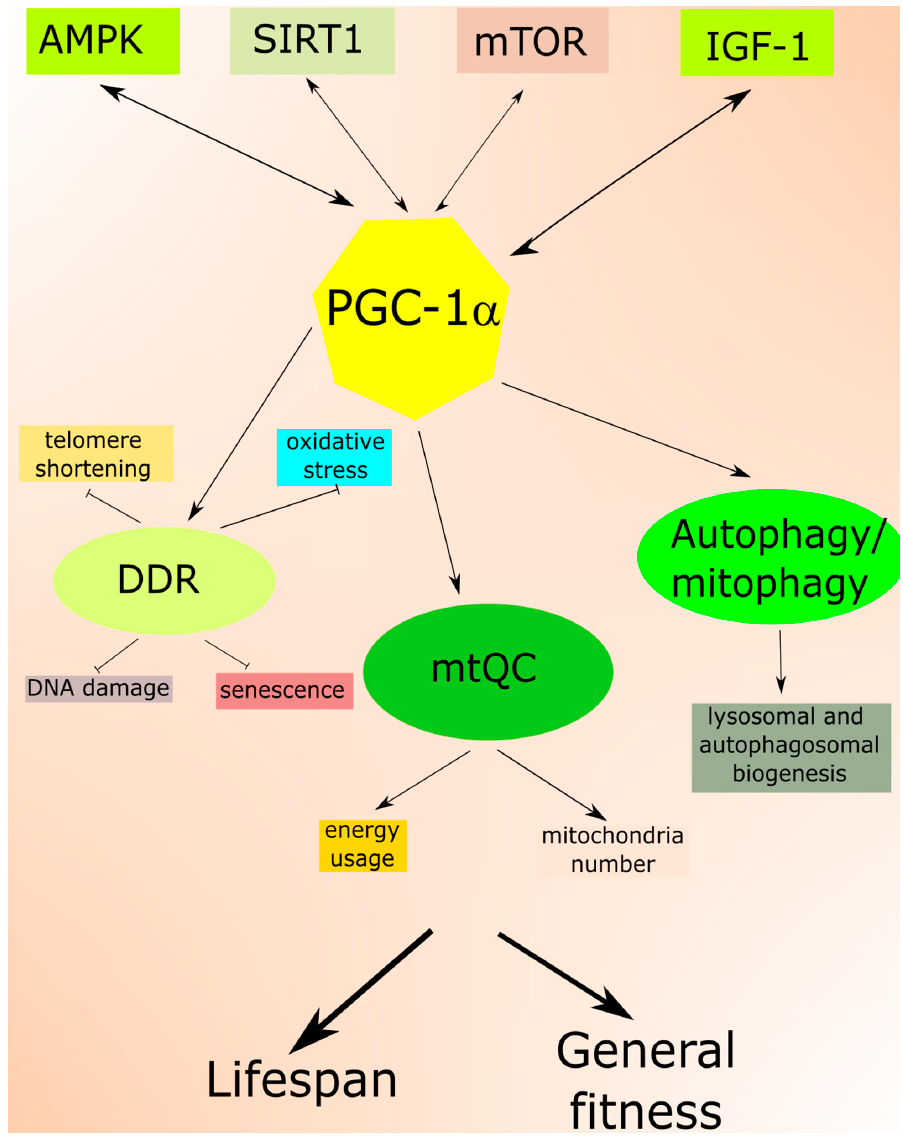
Figure 6. The central role peroxisome proliferation ‐ activated receptor coactivator 1 alpha (PGC ‐ 1 α ) in aging stress response. PGC ‐ 1 α interacts with proteins playing an important role in aging regulation: 5’AMP ‐ activated protein kinase (AMPK), sirtuin 1 (SIRT1), mechanistic target of rapamycin (mTOR) and insulin ‐ like growth factor 1 (IGF ‐ 1). These interactions result in the involvement of PGC ‐ 1 α in the essential aging stress response pathways: DNA damage response (DDR), mitochondrial quality control (mtQC) and autophagy/mitophagy. PGC ‐ 1 α is a primary regulator of antioxidant defense, and in this way, it can ameliorate DNA damage, telomere shortening and oxidative stress ‐ and DNA damage ‐ related senescence. PGC ‐ 1 α controls mitochondrial response to stress associated with low energy allowing mitochondria to adjust their energy usage and number. PGC ‐ 1 α may also contribute to the biogenesis of lysosomes and autophagosomes, essential for autophagy and mitophagy. These effects may extend lifespan and improve general fitness.